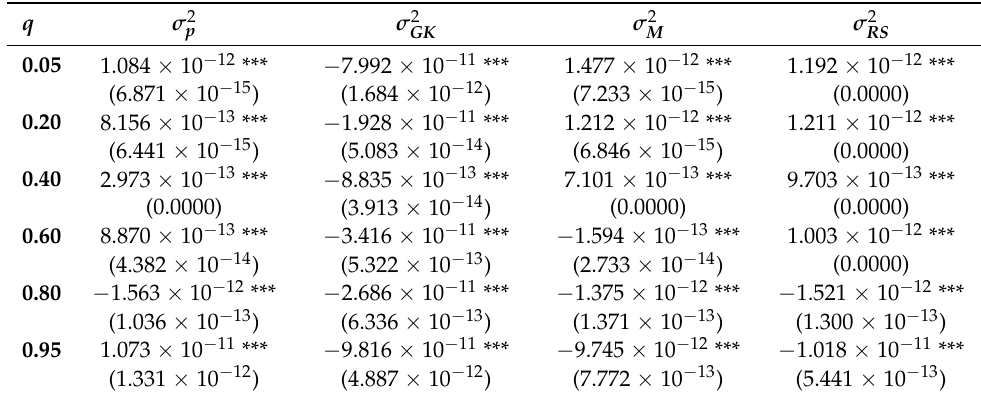
Table 4. Trading volume impact on National Bank of Greece’s stock return volatility.